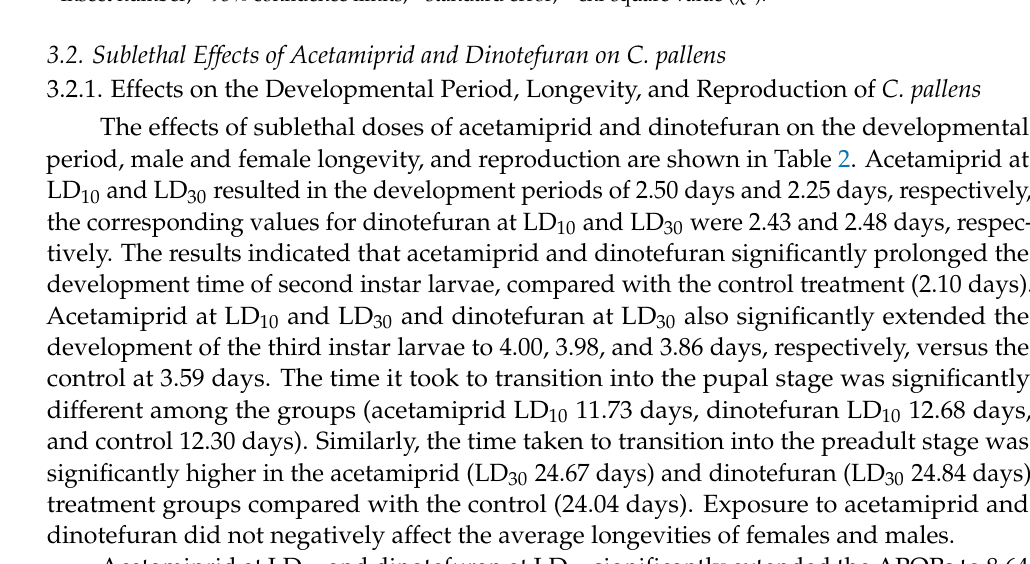
Insecticide N a Acetamiprid